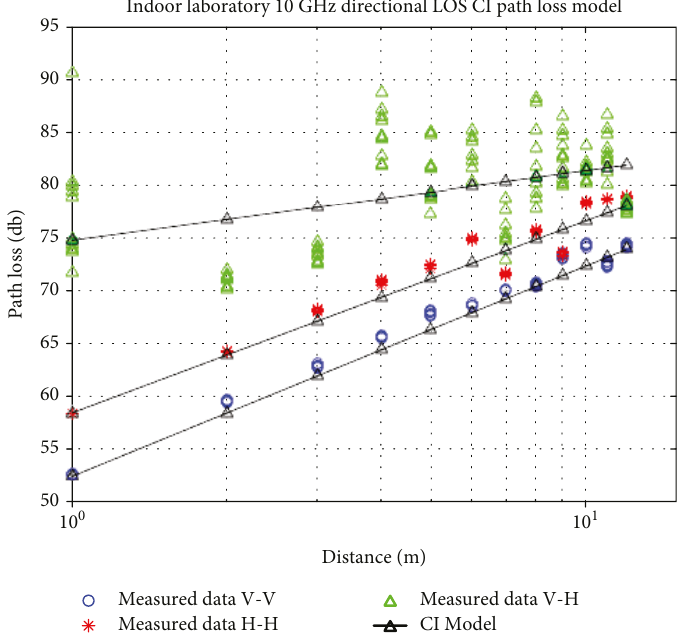
Figure 6: 10 GHz directional LOS large-scale CI path loss model with copolarization V-V, H-H, and V-H in the computer